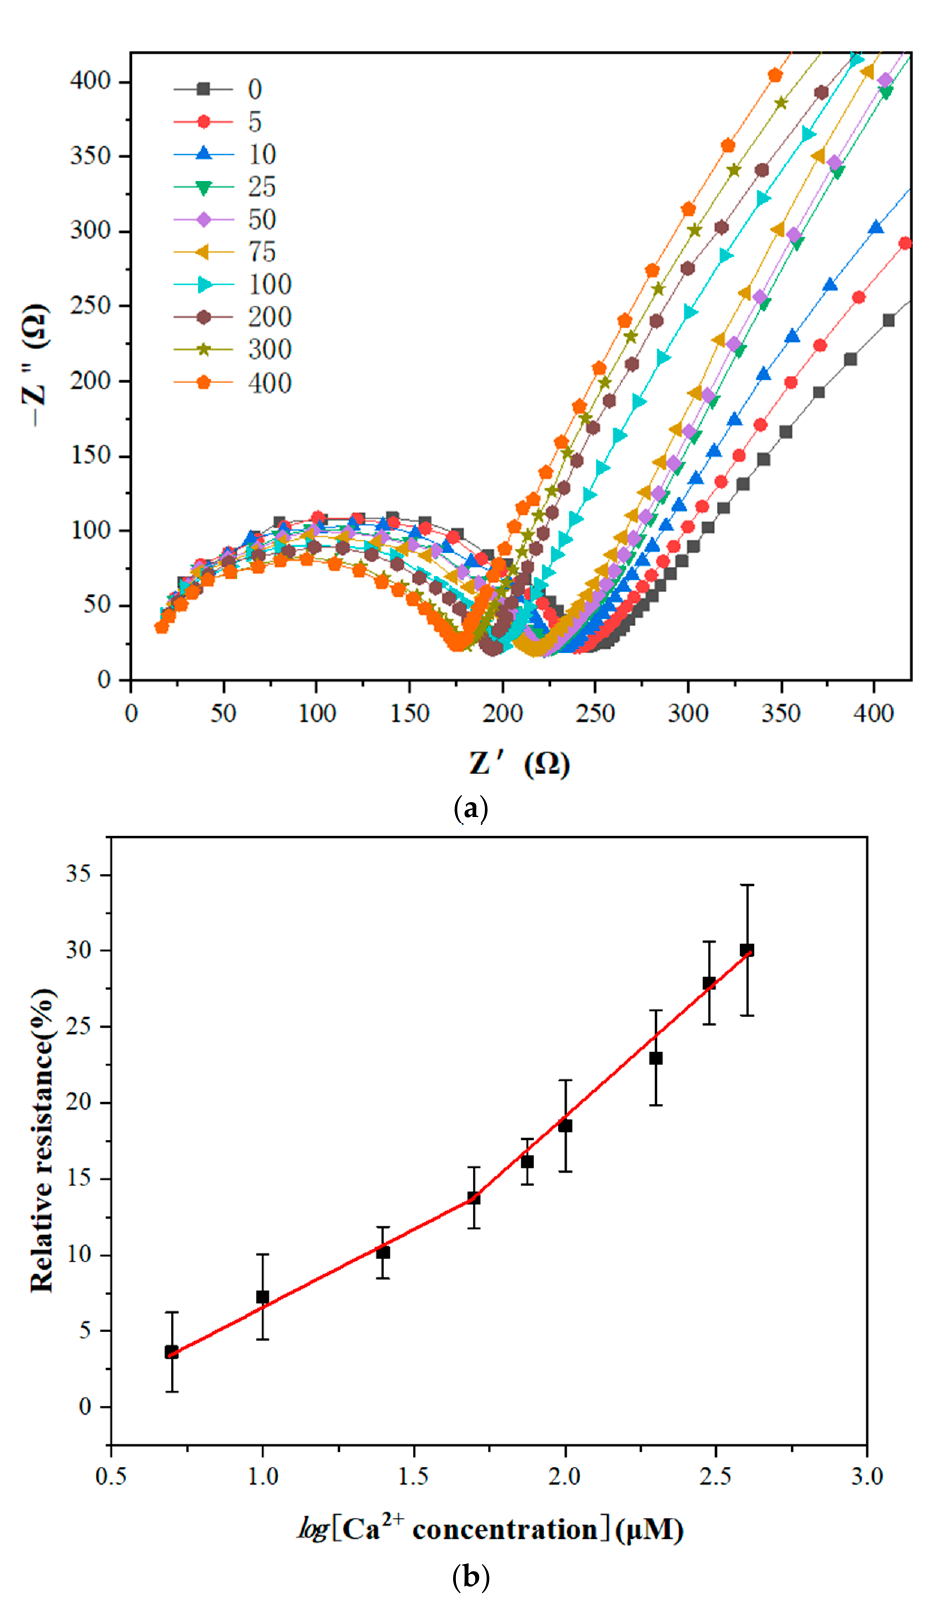
Figure 10. ( a ) Electrochemical impedance spectroscopy of GCE/NGR/AuNPs/Sub-DNAzyme duplex at different Ca 2+ concentrations from 0 µ M to 400 µ M; ( b ) Linear relationship between relative resistance and logarithms of Ca 2+ concentration (The error bars were determined in three dupli ‐ cates).